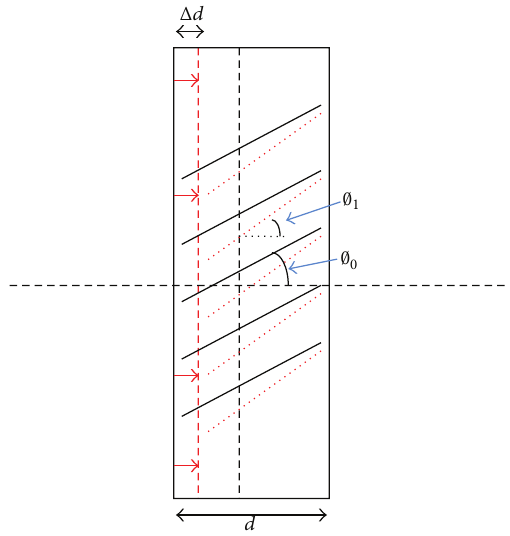
Figure 1: Schematic diagram showing reorientation of fringes in a transmissiongrating as a result ofshrinkage. 0 0 and 0 1 are theinitial and final slant